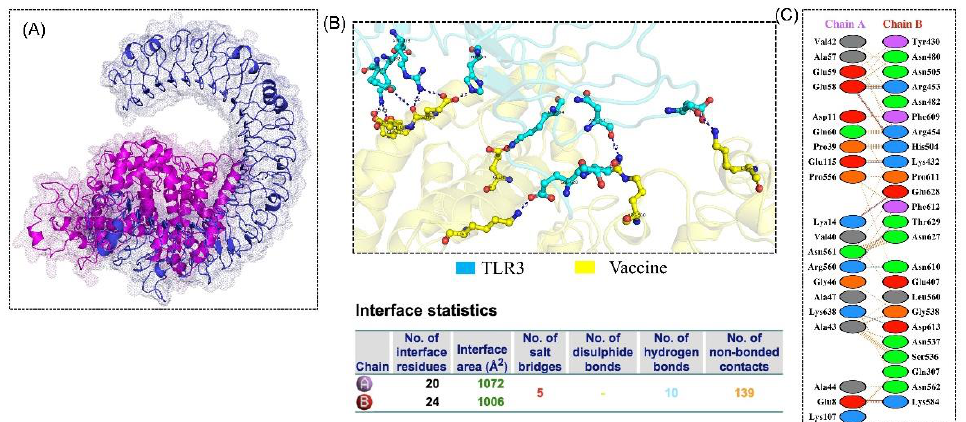
Figure 4. TLR-3-vaccine docked complex. ( A ) The TLR-3(receptor) is shown in blue, while the magenta color represents the multi-epitope subunit vaccine. ( B )The residues interactions in 3D are shown while ( C ) in the right-side panel shows 2D interactions.